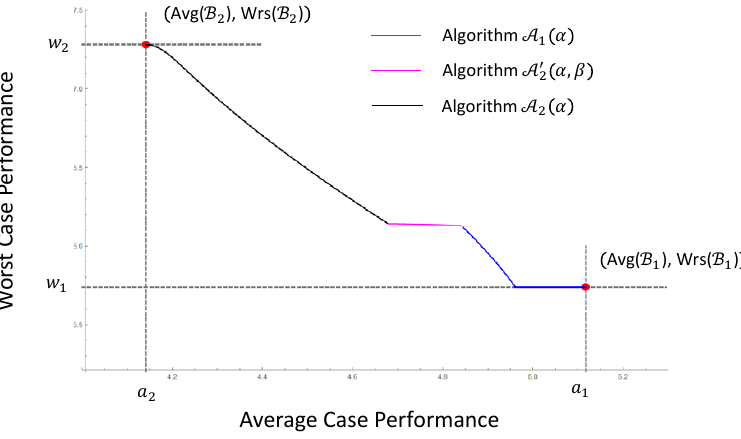
Figure 1. Illustration of the performance of our solution to 2 E VAC w Depicted curve corresponds to parametric curve ( g ( w ) , w ) , where w , g ( w ) are the worst-case performance and average-case performance of three different families of evacuation algorithms A A (cid:48) , A 2 , discussed formally in Section 4. Please note that the magenta curve is not a 1 , 2